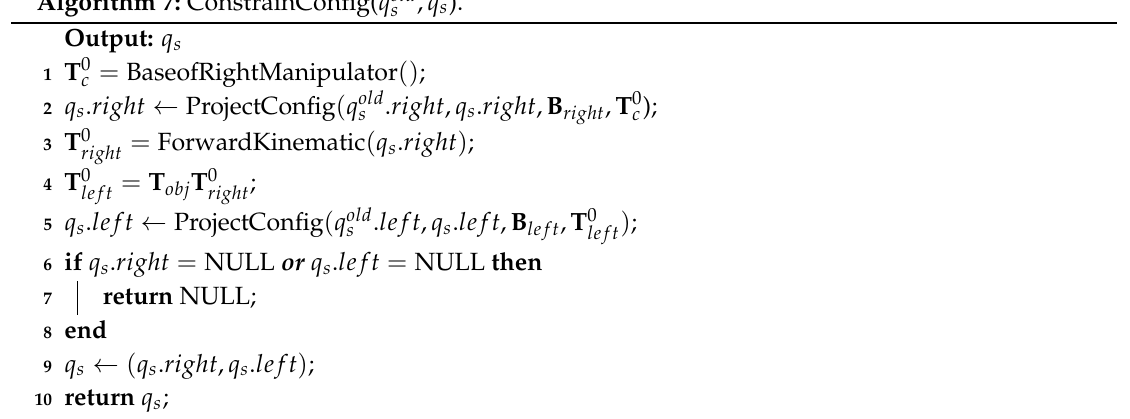
Algorithm 7: ConstrainConfig( q old